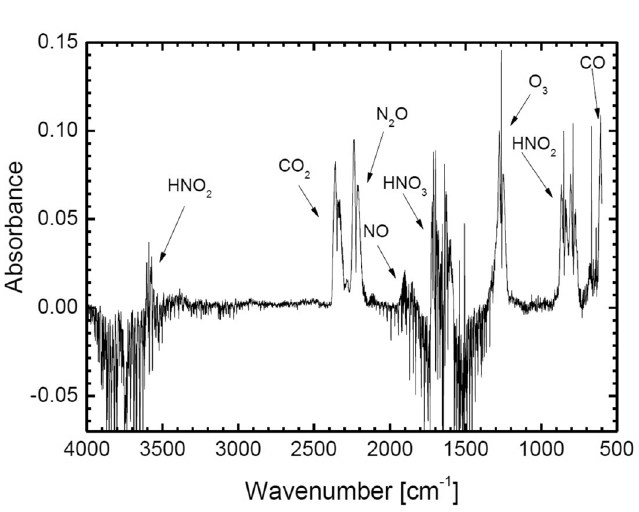
Figure 6. FTIR spectrum of plasma jet during interaction with water in ambient air 27